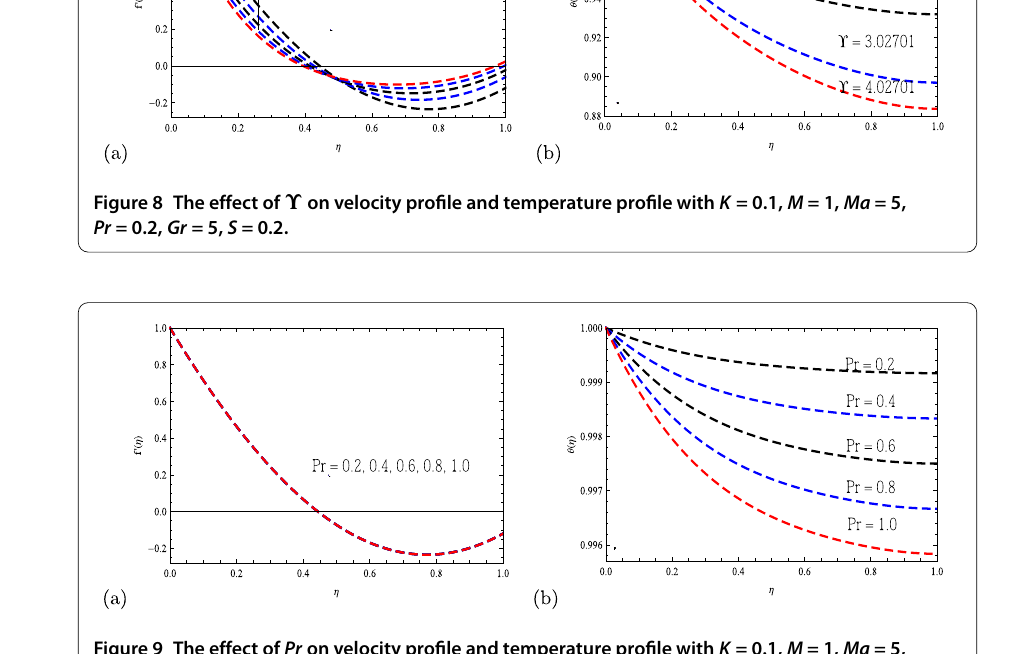
Figure 9 The effect of Pr on velocity profile and temperature profile with K = 0.1, M = 1, Ma = 5, ϒ = 0.027013, Gr = 5, S = 0.2.